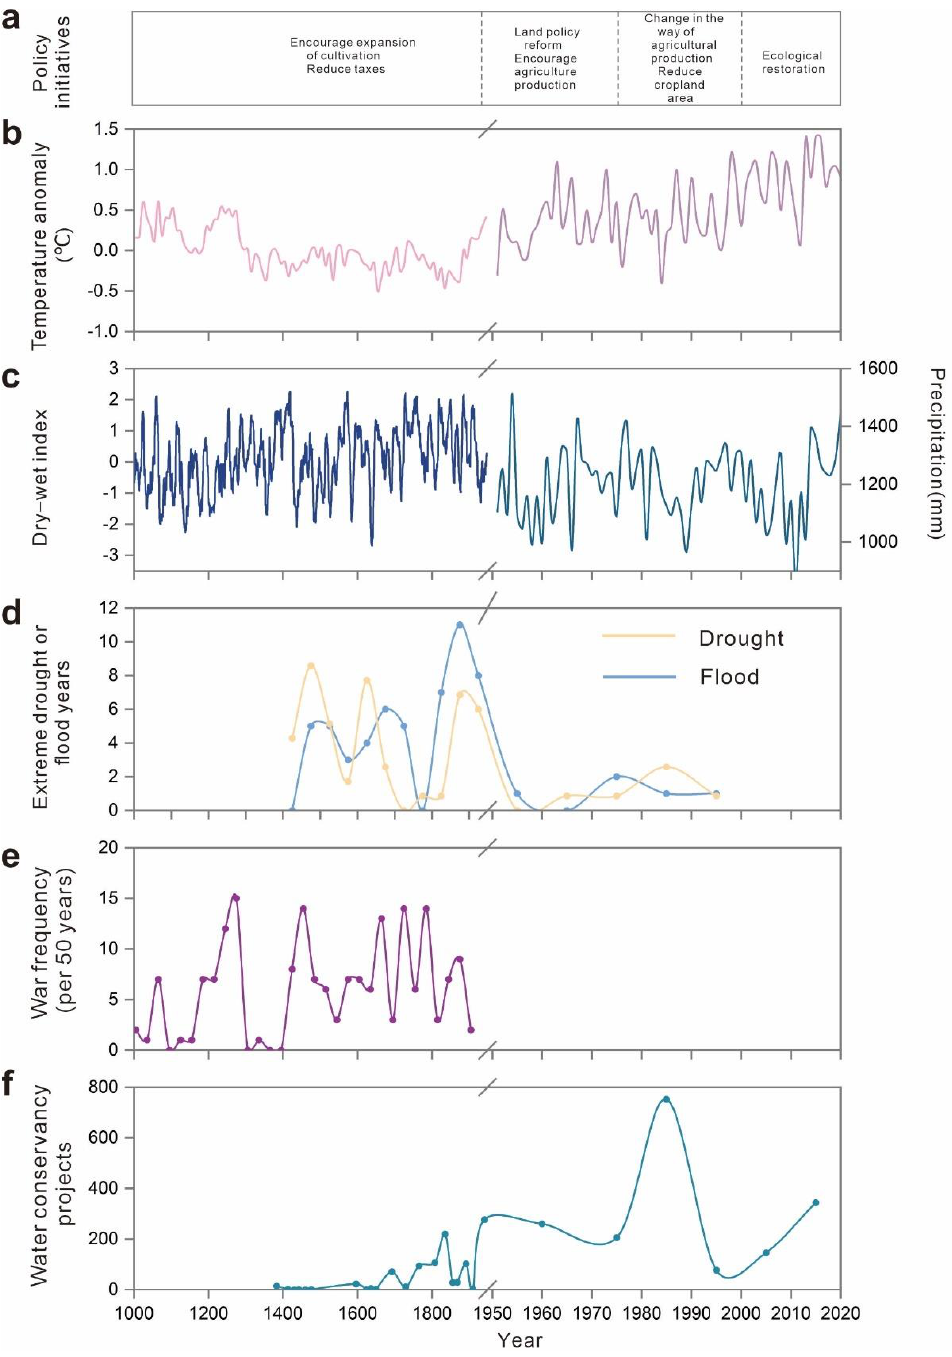
Figure 6. Drivers of changes in socio-ecological interactions of Guizhou Province. ( a ) Policy initiatives, ( b ) temperature anomaly, ( c ) dry-wet index, ( d ) extreme drought or flood years, ( e ) war frequency, ( f ) water conservancy projects.